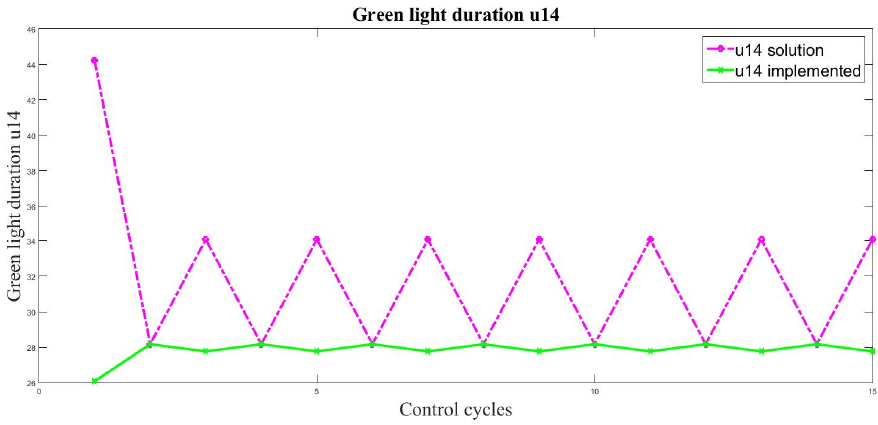
Figure 9. Difference between the evaluated and implemented green light duration u 8 .